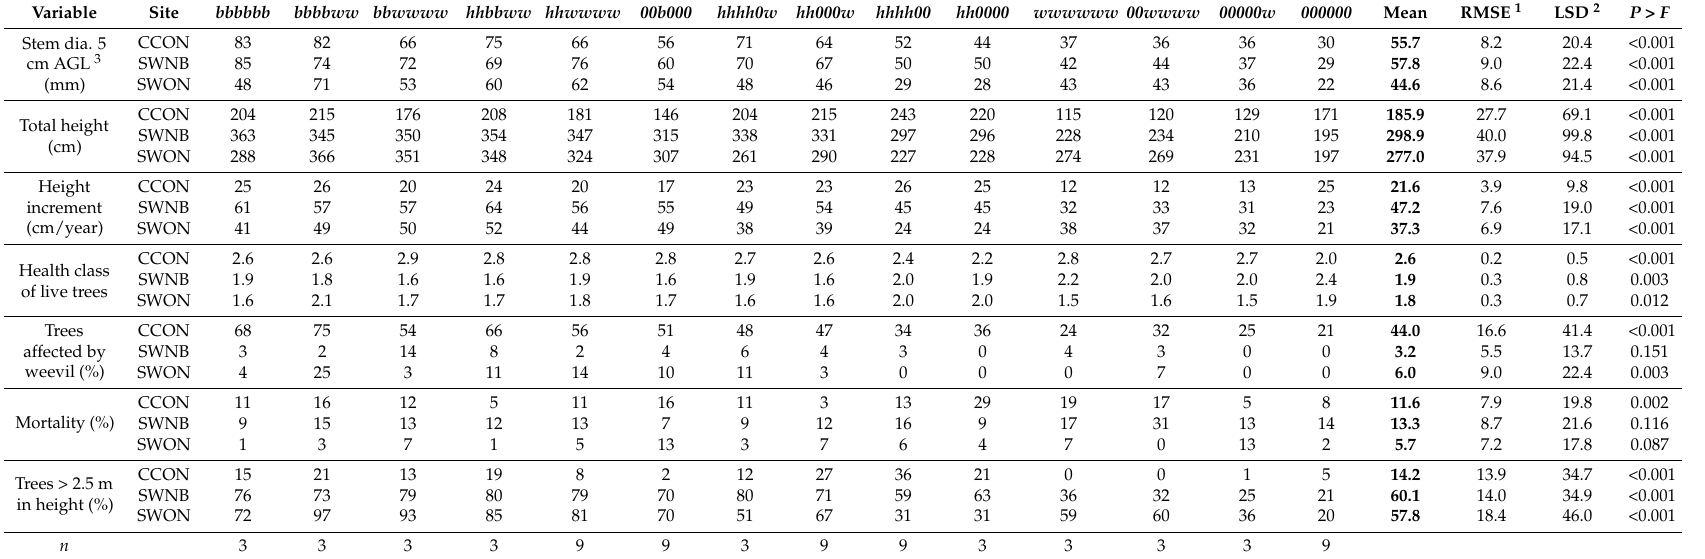
Table 1. Treatment mean responses for planted pine at age